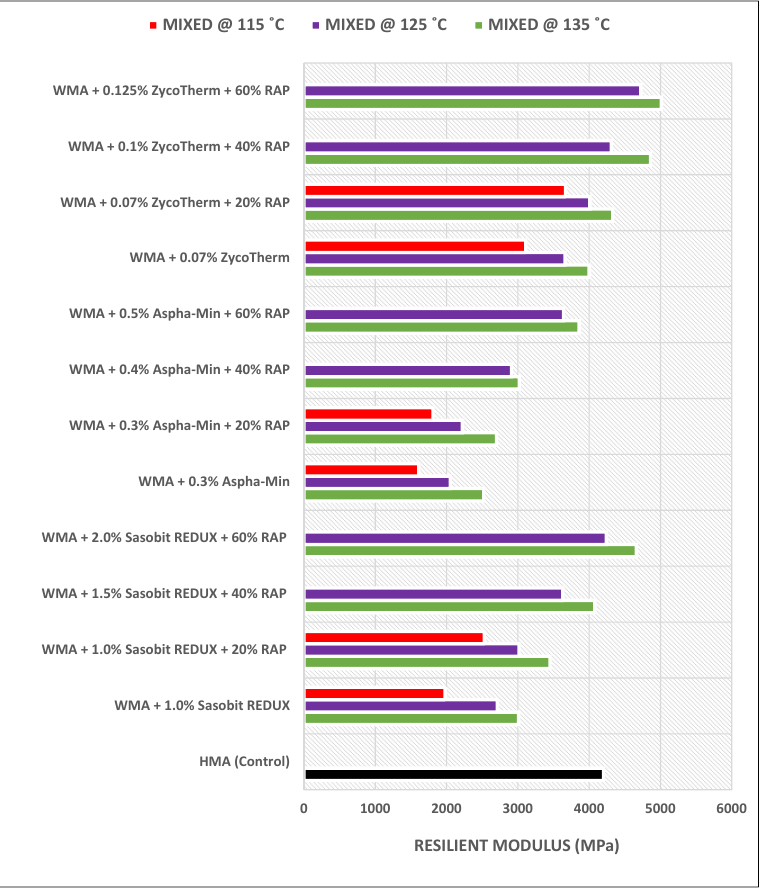
Figure 20. The results of resilient modulus (M R ) test.